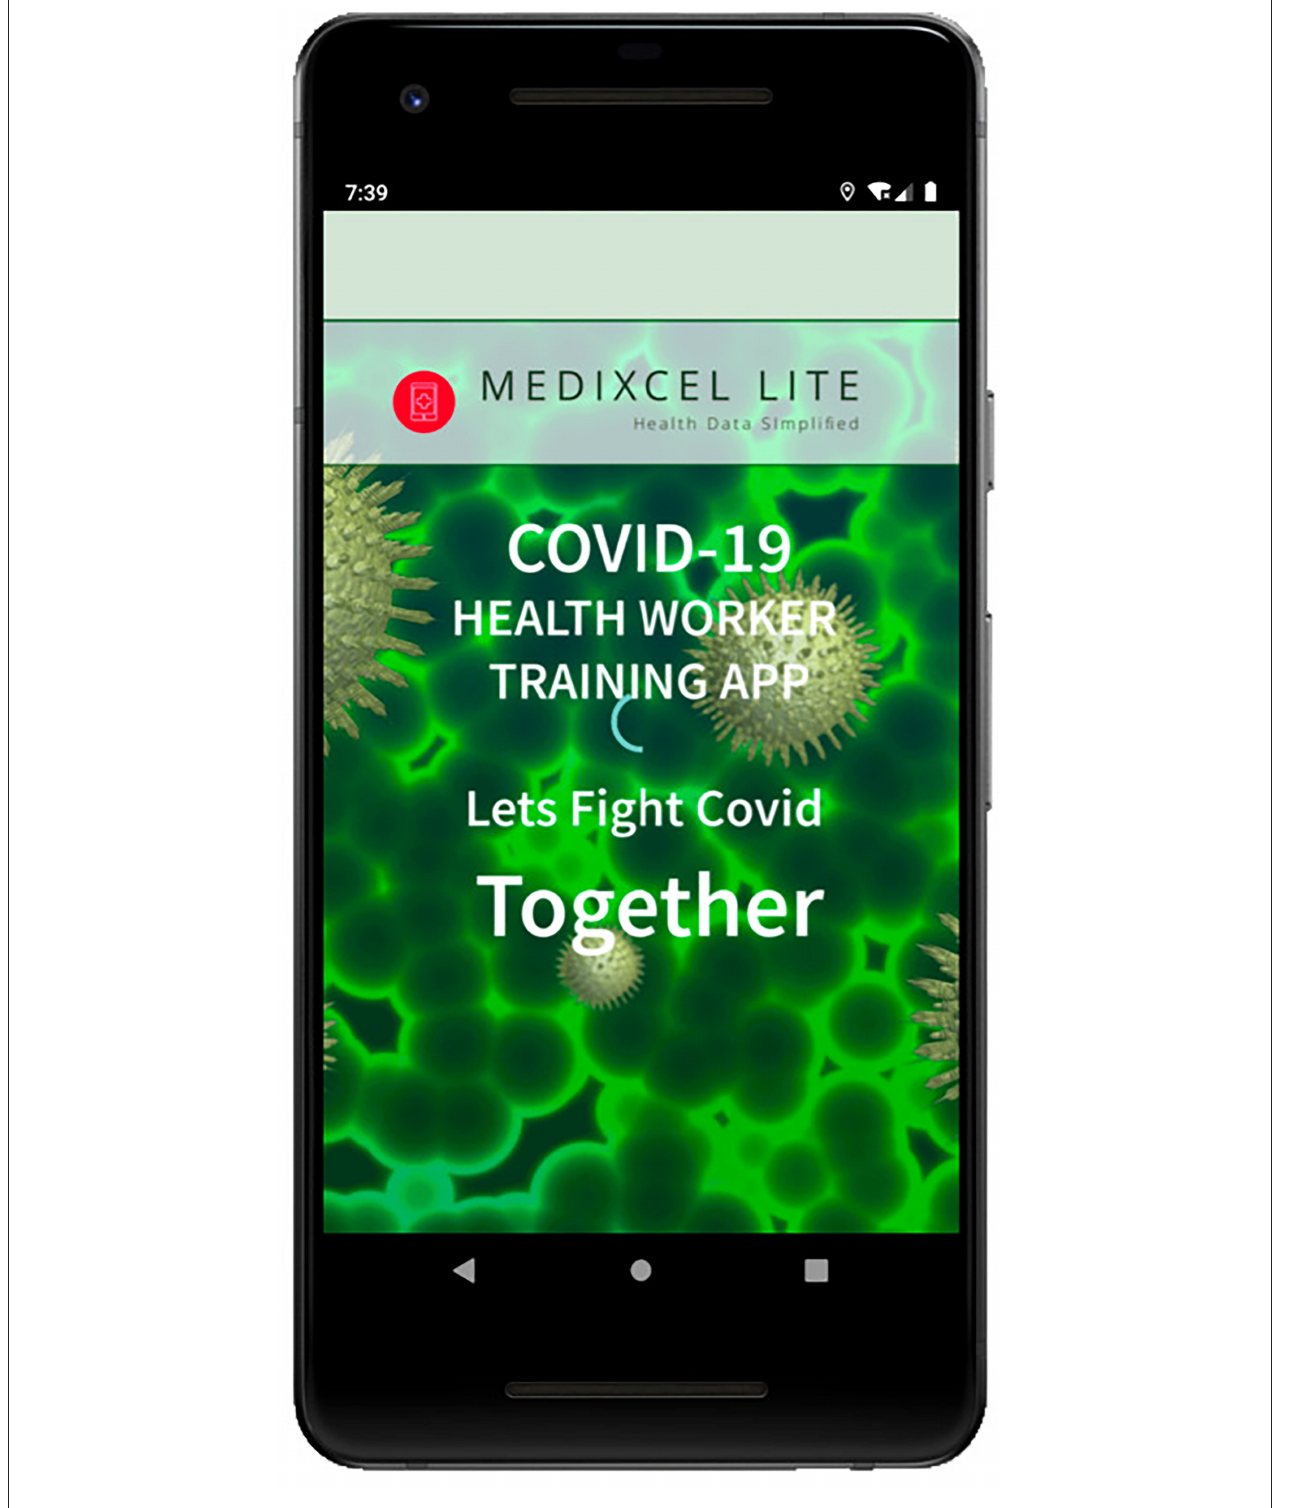
FIGURE 2 | An android phone showing the homepage of the InStrat COVID-19 Mobile App.